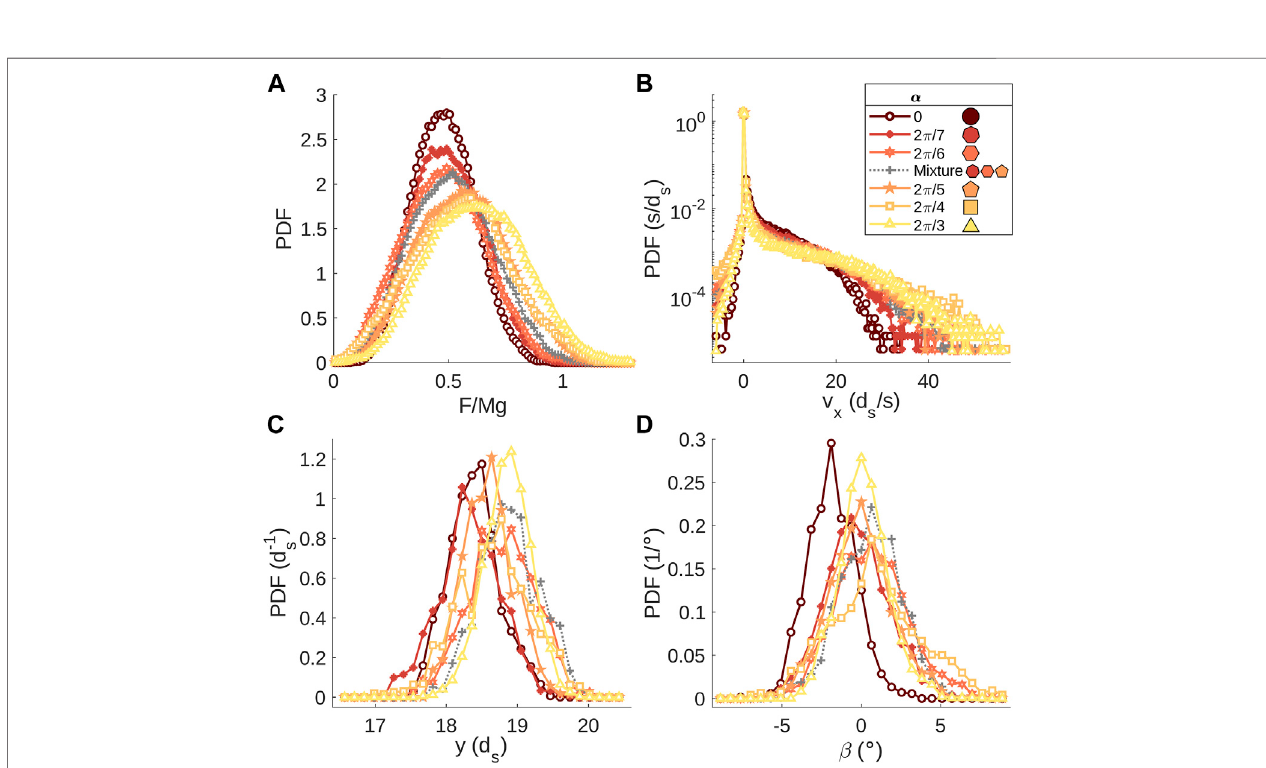
FIGURE4| PDFs ofvarious quantities describing motion and position oftheslider. All distributionsare produced from the combined time series ofall experimental runs foreach packing. (A) PDF ofthenormalizedpulling force ontheslider. (B) PDF ofthe horizontal component oftheslider ’ svelocity. (C) PDFofthevertical positionof the slider. (D) PDF of the angle of the